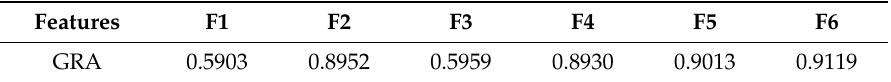
Table 1. Grey relational grades between the features and state of health (SOH).